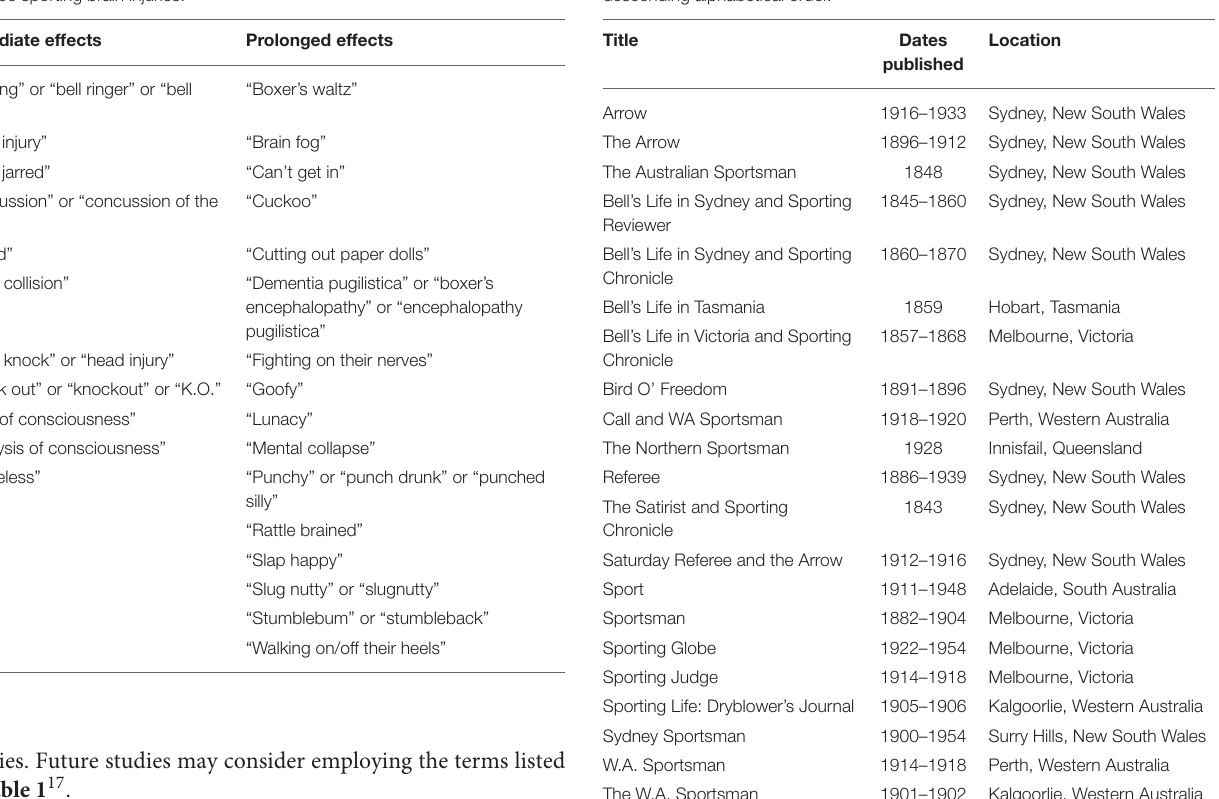
TABLE 2 | List of Australian sporting newspapers in the Trove archive, in descending alphabetical